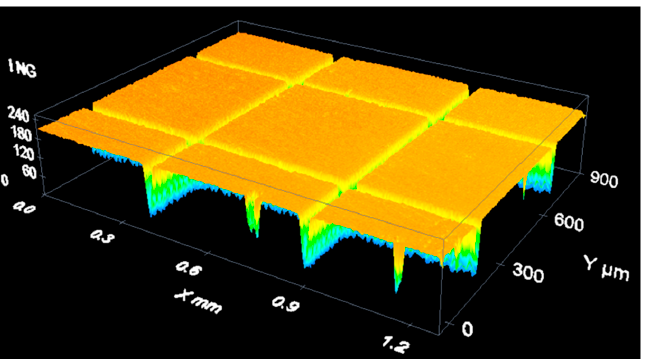
Figure 14. Proof of concept pattern seen in a confocal microscope at 10× magnification.